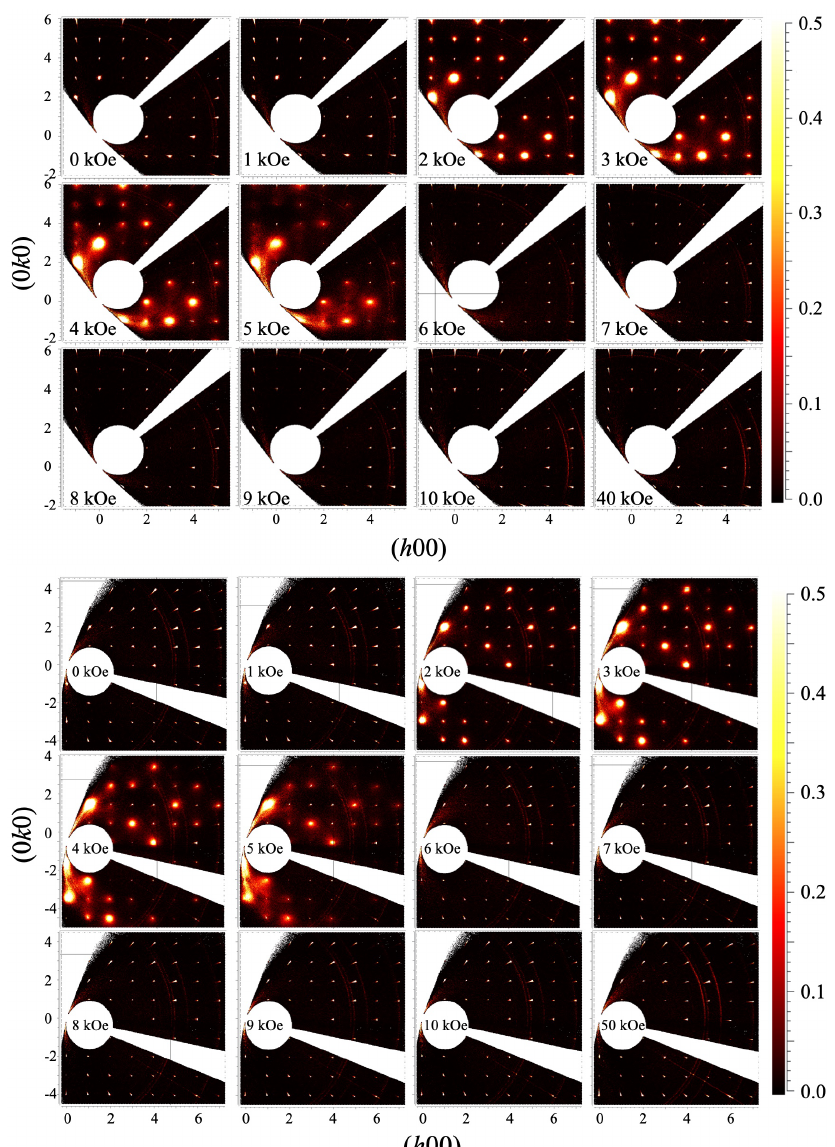
Figure A4: Neutron diffraction intensity maps (background subtracted) of the ( hk 0 ) plane for SrEr O measured on the WISH instrument at T = 60 mK in different fields 2 4 applied parallel to the c